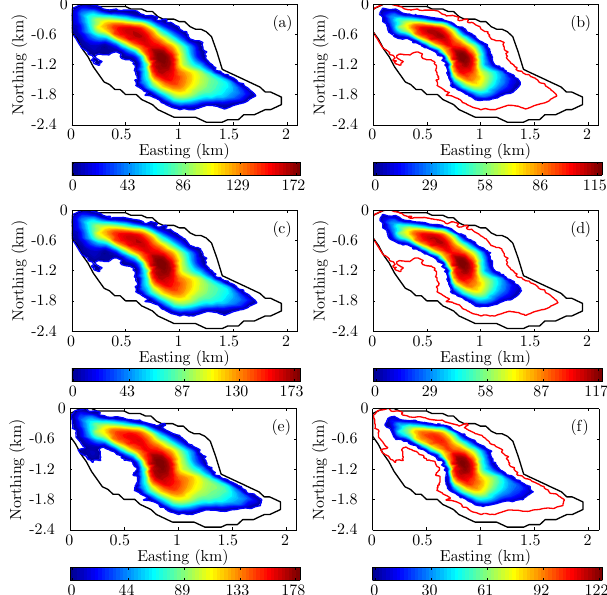
Fig. 12. Distribution of ice thickness (m) in Haig Glacier at 2025 (left panel) and 2050 (right) under the RCP4.5 emission scenario. Results are shown for (a–b) FS, (c–d) PS, and (e–f) SD models. Black and red lines depict the present-day and 2025 glacier out- lines, respectively. Notice that, for better readability, we use differ- ent color scales for each model case.